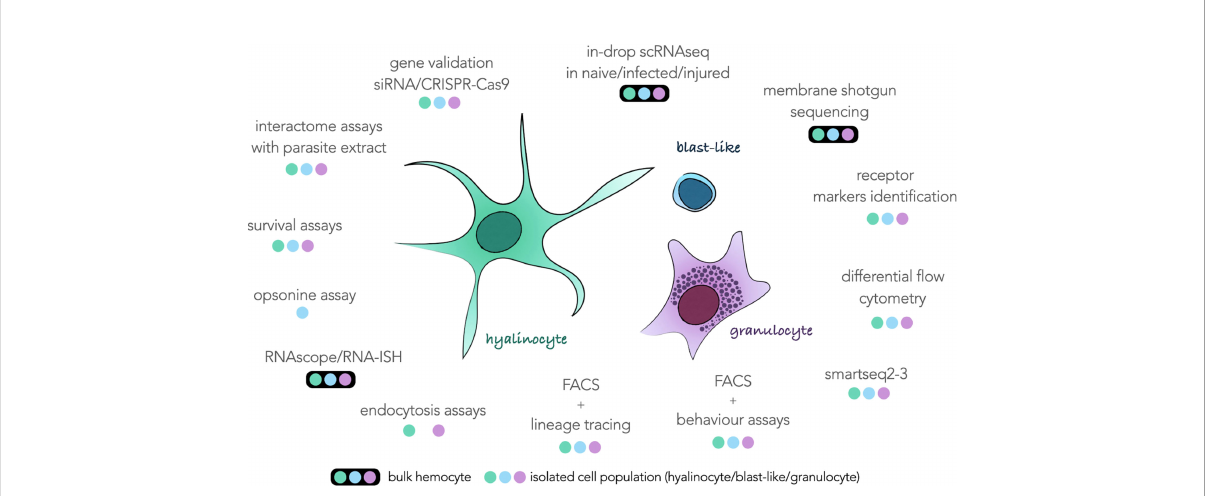
FIGURE 3 Schematic representation of the three hemocyte populations commonly described surrounded by all the techniques feasible on this type of cell and taking into account either bulk hemocytes (colored dots circled in black) or hemocytes taken individually (colored dots) according to their morphological characteristics. The three colored dots refer to the colors of each hemocyte population in the center of the fi